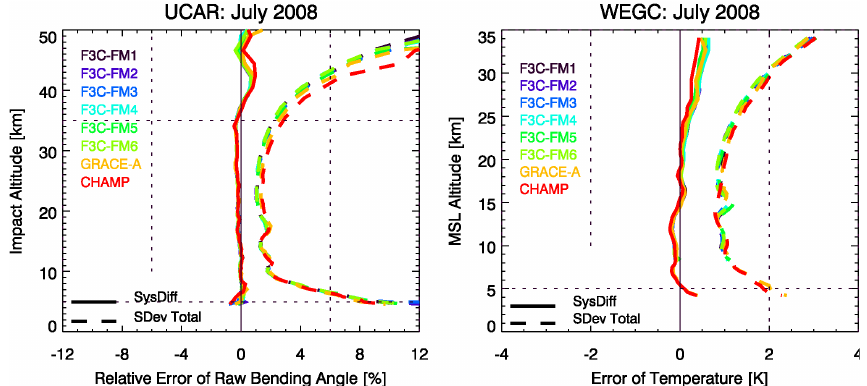
Fig. 1. RO minus ECMWF systematic difference (solid) and standard deviation (dashed) in July 2008 for UCAR raw bending angle (left panel) and WEGC dry temperature (right panel). Note different x- and y-axes of the two